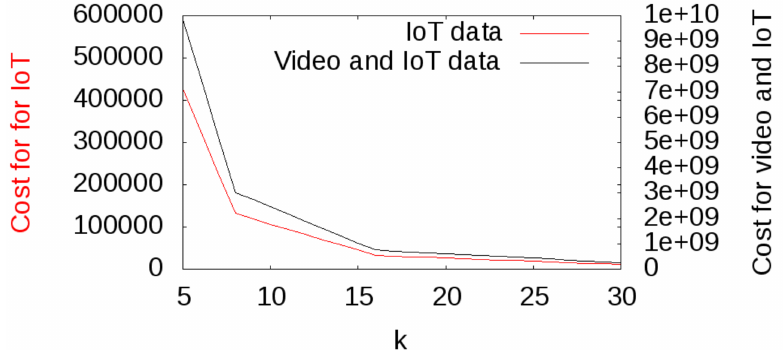
Figure 13. The bisecting- k -means clustering for IoT only and video/IoT scenarios. The diagram illustrates average distances to the cluster centroid with different numbers ( k ) of clusters. The left side y-columns provide value for IoT data (red curves) and the right side y-columns provide values for video/IoT data (black